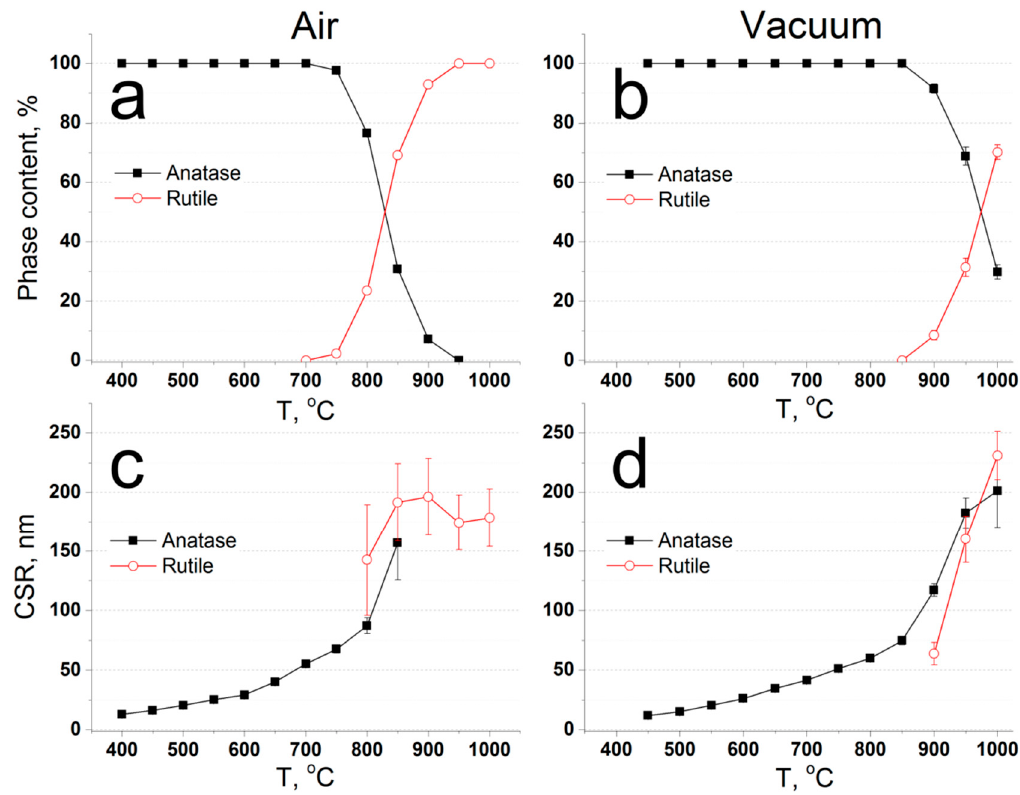
Figure 6. High-temperature XRD data: phase composition of the samples, annealed in air ( a ) and in vacuum ( b ), and the coherent scattering region sizes of the samples, annealed in air ( c ) and in vacuum ( d ).